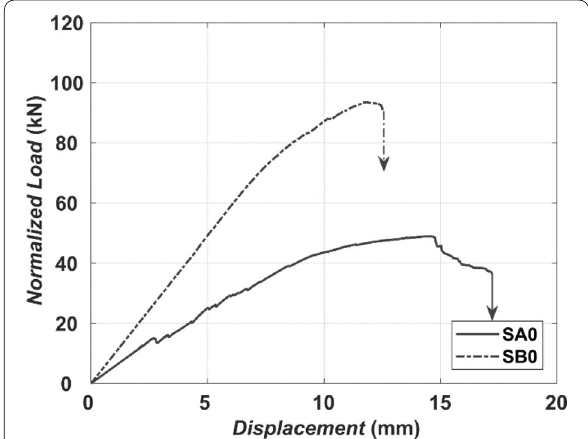
Fig. 9 Load–deflection curves of the control specimens SA0 and SB0, identical except for the slab thickness and hence the slab‑to‑depth ratio.